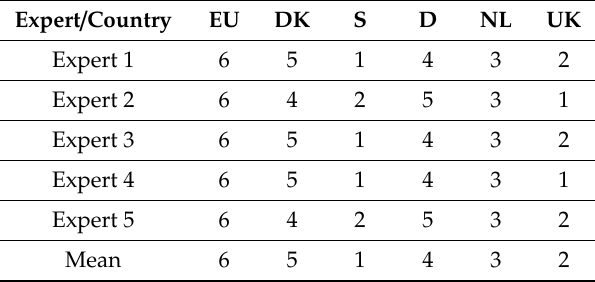
Table 2. Ordering of Benchmark scores for pig production in the five countries, including a situation where only the minimal European Union requirements apply, based on the values and weight for each expert in turn, and the mean. Expert / Country EU DK S D NL UK Expert 1 6 5 1 4 3 2 Expert 2 6 4 2 5 3 1 Expert 3 6 5 1 4 3 2 Expert 4 6 5 1 4 3 1 Expert 5 6 4 2 5 3 2 Mean 6 5 1 4 3 2 1 = best Benchmark score, 6 = worst Benchmark